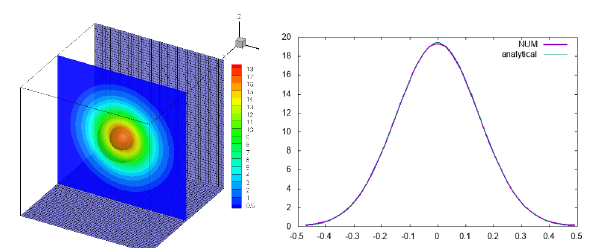
Fig. 1. 3D di ff usion: simulation and comparison with the ana- lytical solution at time t = 0 . 01 s , x 1 -cut through the